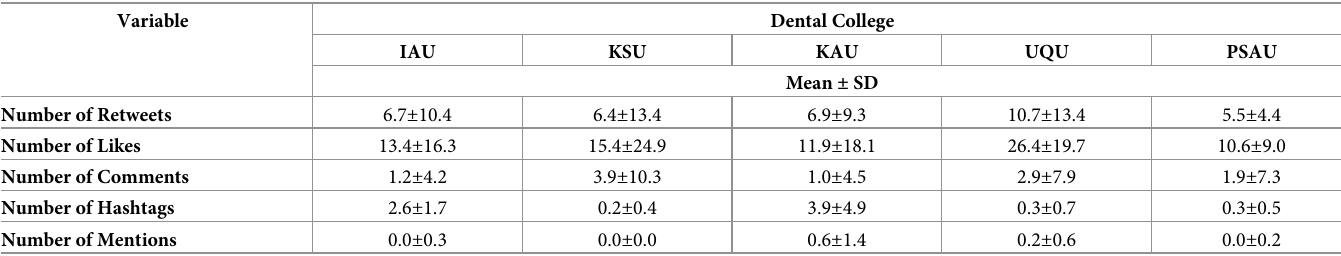
Table 4. Measures of tweets engagement for the top five dental schools.